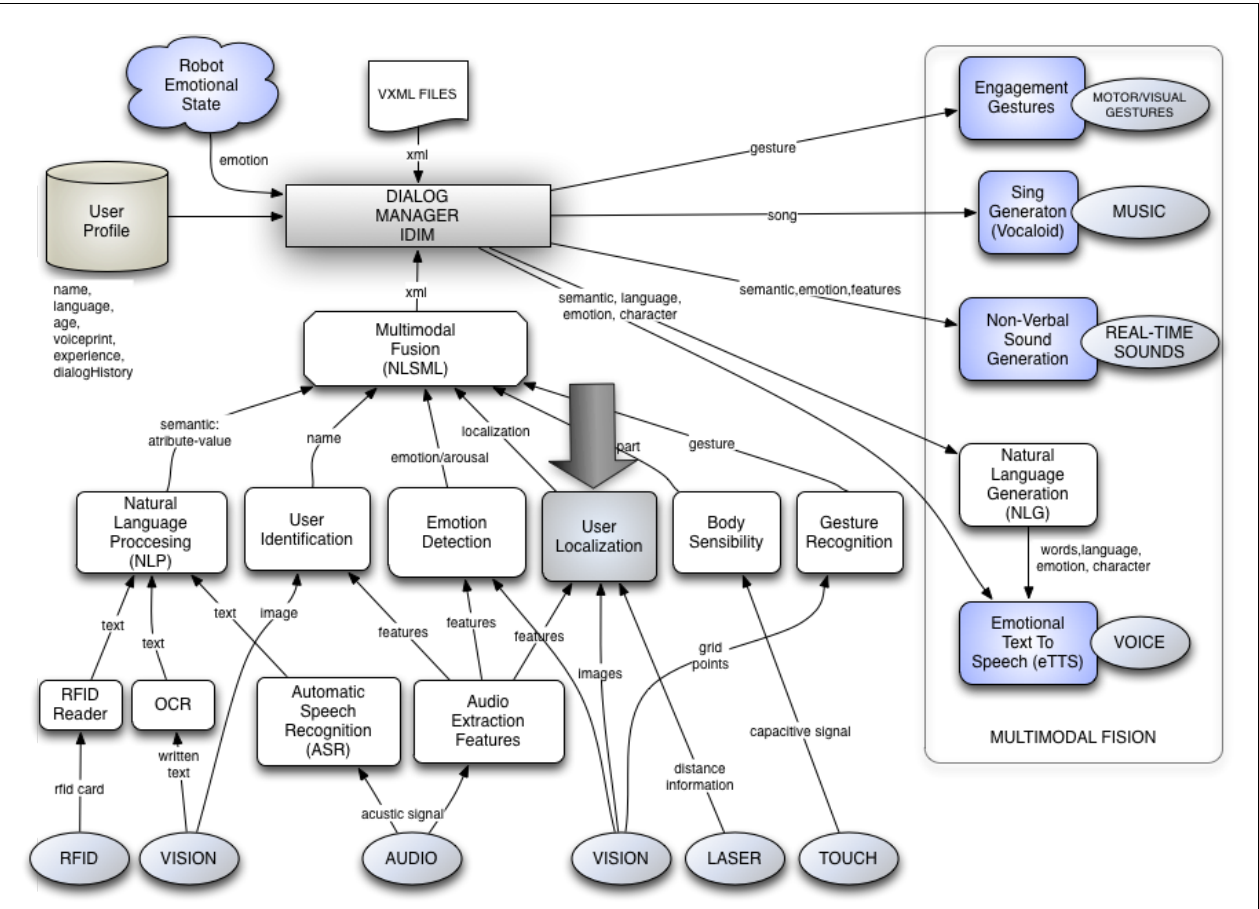
Figure 9. Multimodal dialog system in